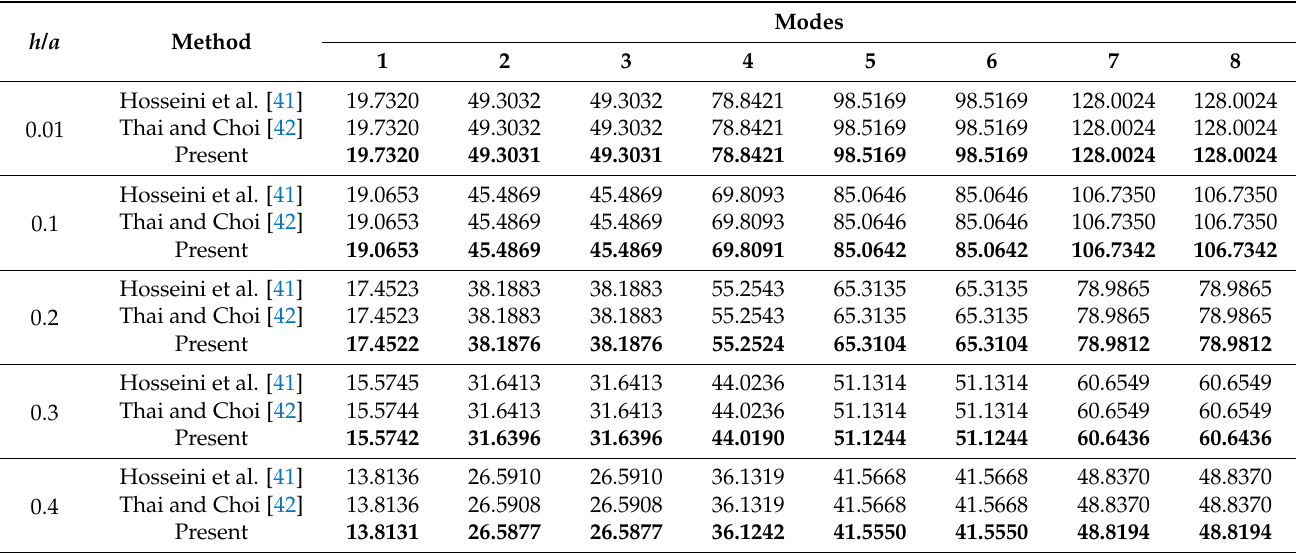
Table 2. Comparison of the first eight non-dimensional frequencies (cid:101) ω of simply supported